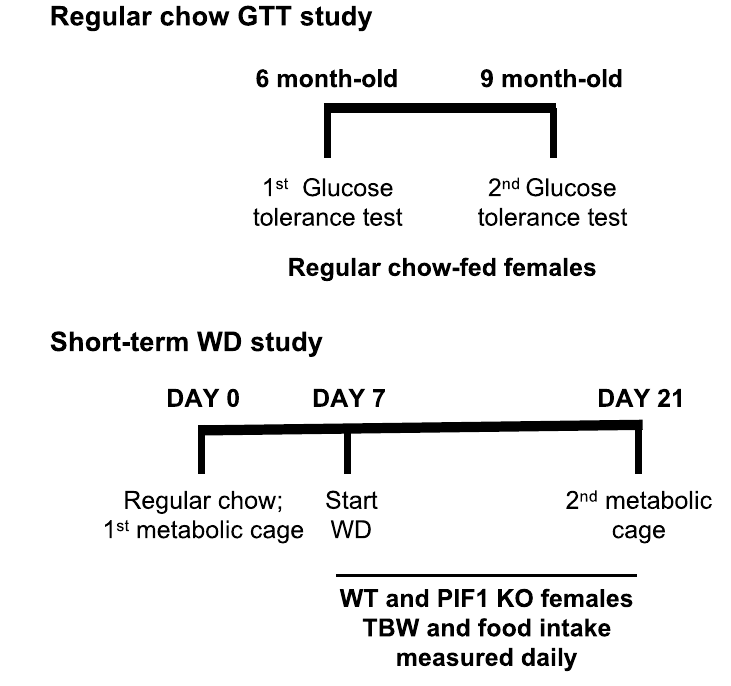
Fig 1. Experimental timelines for each cohort. A) Long-term Western diet (WD) study. Starting at 2 months of age, males and females undergo WD feeding with weekly measurements of total body weight (TBW). Females also had food intake, metabolic cage experiments, and glucose tolerance tests at the indicated weeks. B) A second cohort of 2-month-old, regular chow-fed WT and PIF1 KO females underwent glucose tolerance tests at 6 and 9 months of age. C) A separate cohort of 9-week-old WT and PIF1 KO females were fed regular chow and were used in the first metabolic cage experiments on Day 0 (TBW and food intake measured daily through Day 21), followed by the start of WD feeding on Day 7 through Day 21. The mice were analyzed in a second metabolic cage assessment and subsequently euthanized. week-old WT and PIF1 KO males and females exclusively fed a WD (41% fat, 27% sucrose, 19% protein, per calories; no. 96001; Harlan Teklad, Madison, WI) for 16 weeks (8–12 per group). Four mice of the same sex, genotype and age were group housed together. Total body weight for all mice was measured weekly for 16 weeks. Separately, a second cohort consisted of 2-month-old WT and PIF1 KO female mice that were fed a regular chow diet (14% fat, 60% carbohydrates, 26% protein; no. 5P76; LabDiet, St. Louis, MO.) beginning at the time of wean- ing at 1 month of age through 9 months (10 per group). A third experimental cohort for short-